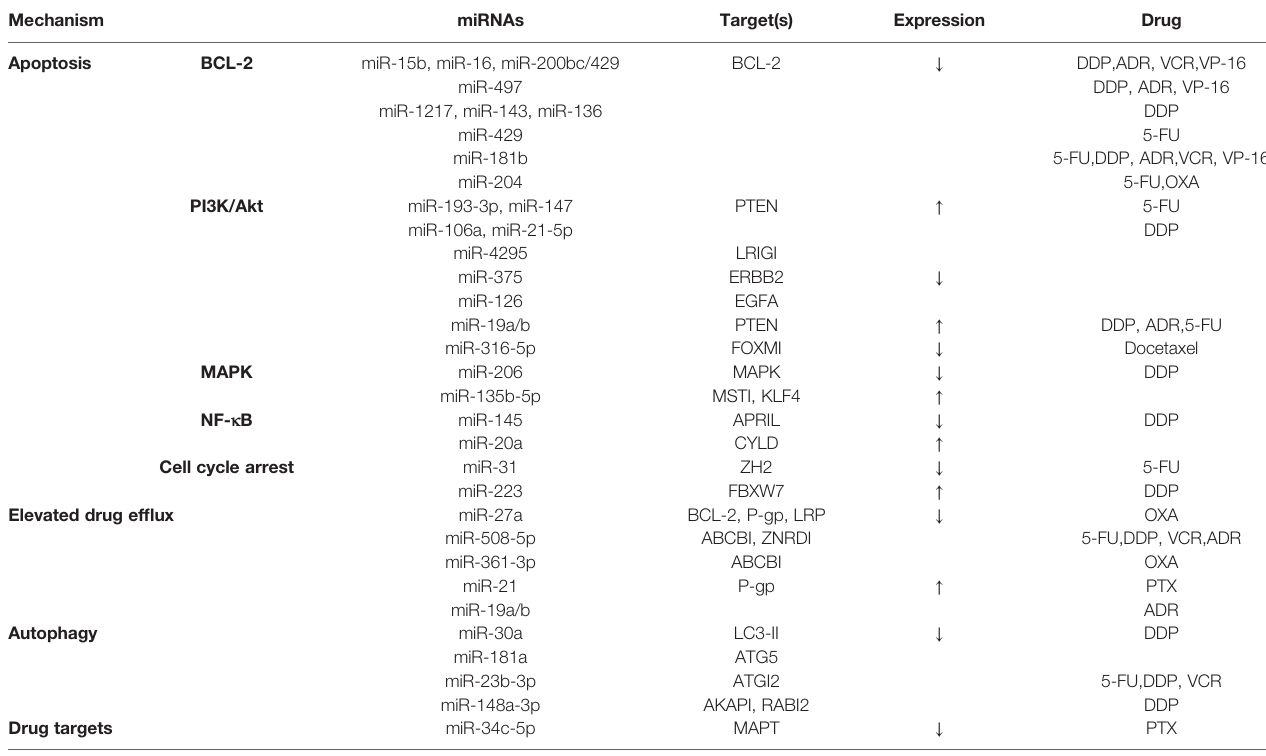
TABLE 1 | The potential mechanism of miRNAs for causing chemotherapy resistance in GC.